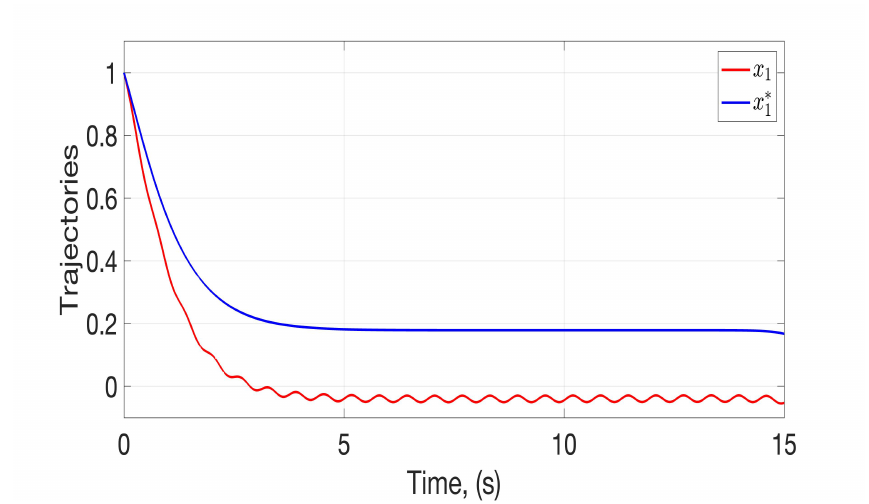
Figure 2. Temporal evolution of the first state x 1 considering the initial iteration ( k = 0) and the final iteration ( k = 2600).